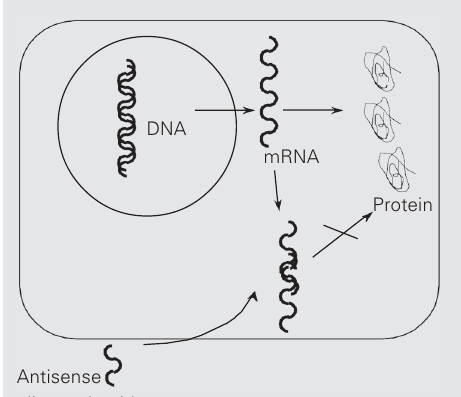
Figure 1. Scheme of the anti- sense approach to the specific inhibition of gene